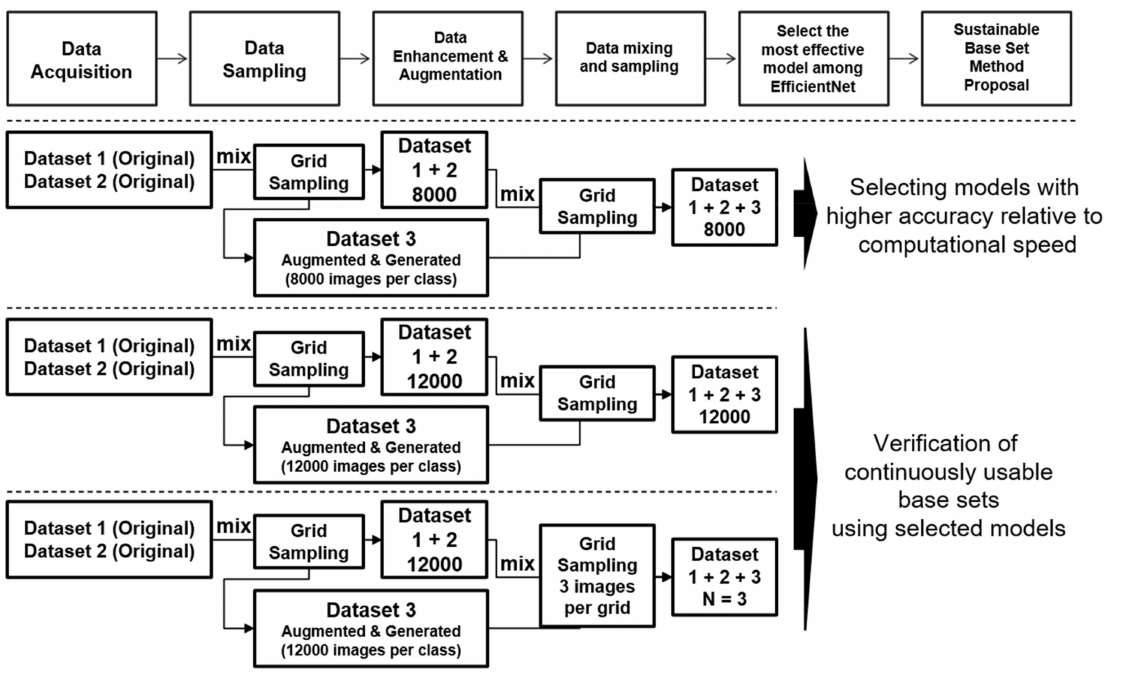
Figure 13. The processes of the proposed